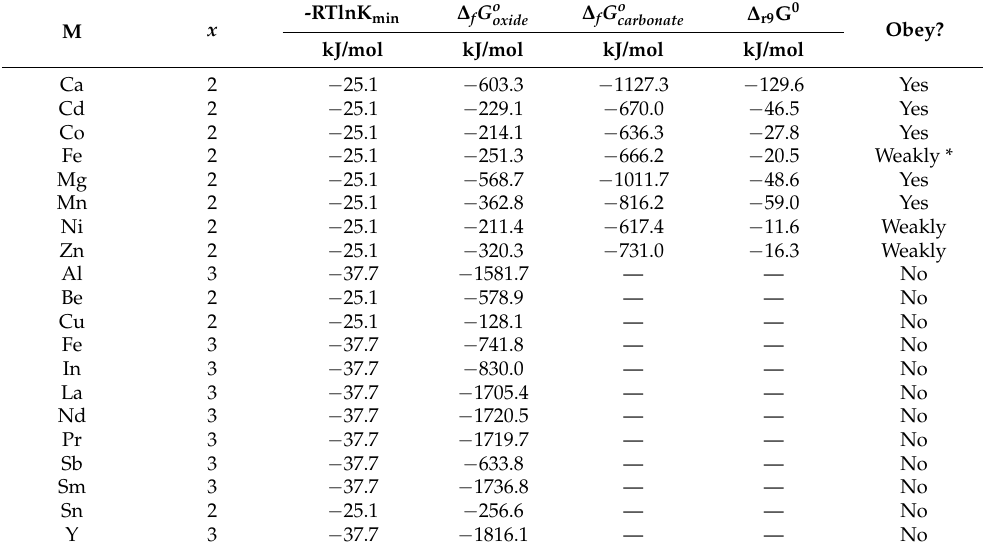
Table 6. Ability of metal oxides to capture CO 2 from air at T = 300 K at least down to 42 ppm or below (among those oxides that passed conditions I-IV